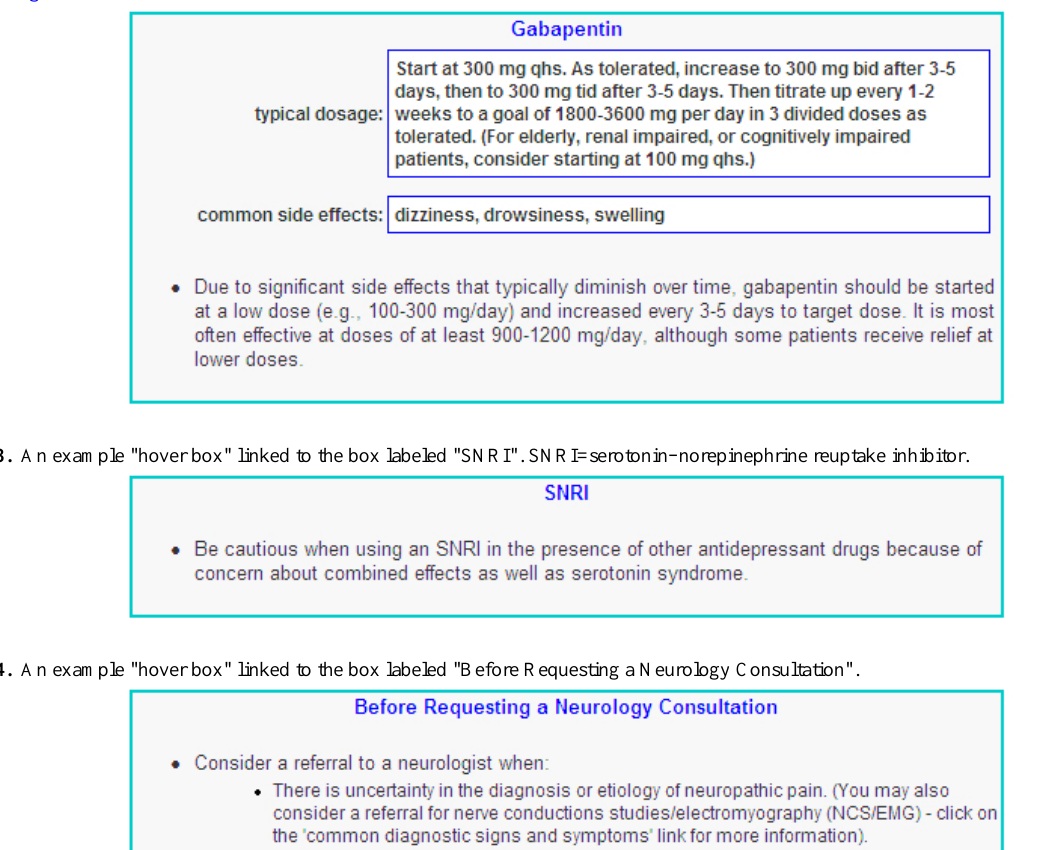
Figure 2. An example "hover box" that appears when the user "hovers" the mouse over the box labeled "Gabapentin" near the bottom of the screen shown in Figure 1.